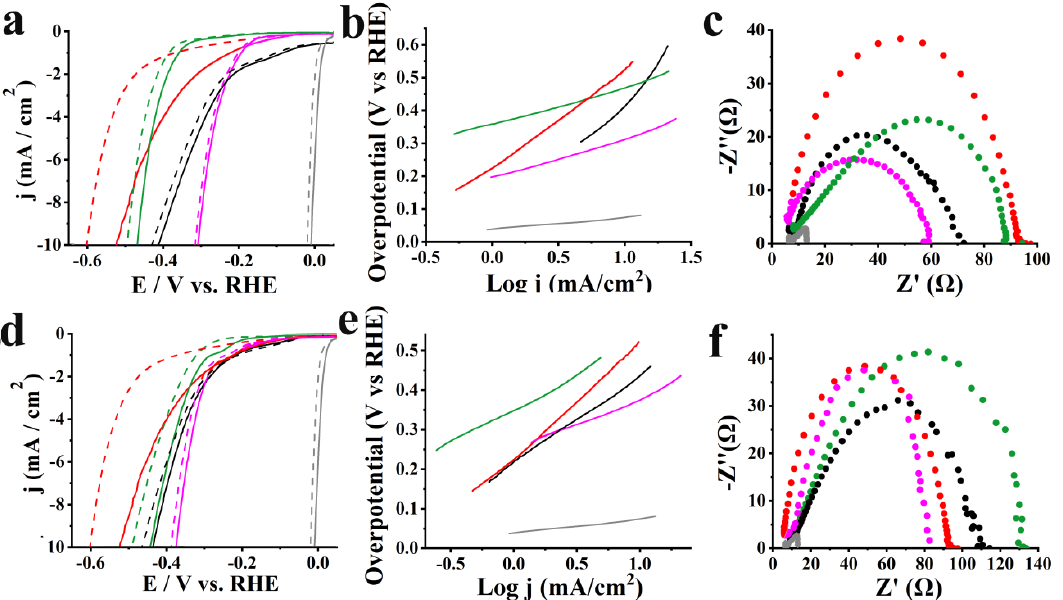
Figure 7. ( a ) LSVs for HER obtained at 1600 rpm rotation speed and 5 mV/s scan rate before (solid lines) and after 10,000 cycles (dashed lines) in aqueous 0.5 Μ H 2 SO 4 , ( b ) Tafel slopes, and ( c ) Nyquist plots for MoSe 2 -CoP (pink), MoSe 2 (black), f-MoSe 2 (green), CoP (red) and Pt/C (grey). ( d ) LSVs for HER obtained at 1600 rpm rotation speed and 5 mV/s scan rate before (solid lines) and after 10,000 cycles (dashed lines) in 0.5 Μ H 2 SO 4 , ( e ) Tafel slopes, and ( f ) Nyquist plots for WSe 2 -CoP (pink), WSe 2 (black), f-WSe 2 (green), CoP (red) and Pt/C (grey). Tafel slope values were extracted to gain information on the reaction